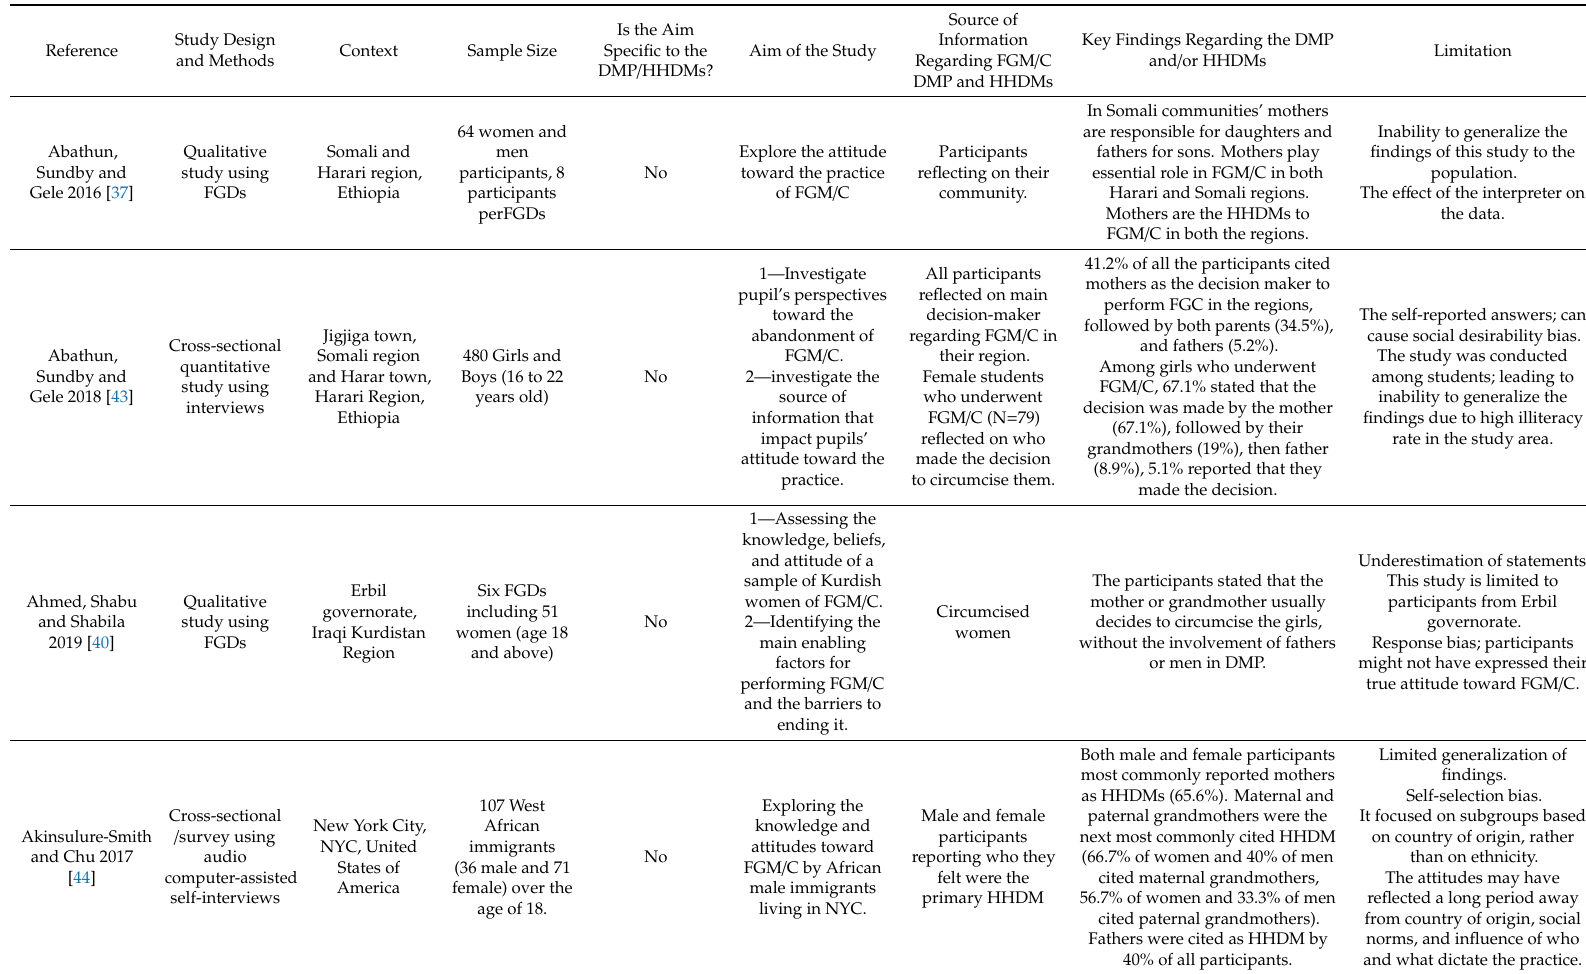
Table 5. Data extraction table (characteristics of the 17 papers included in the review and summary of their